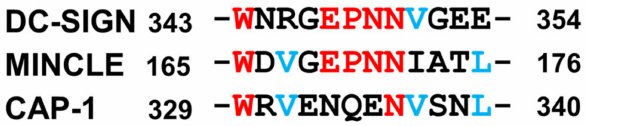
Figure 10. EPN sequence among DC-SIGN and Mincle, and similar sequence in CAP-1 Identical amino acids among 3 sequences were shown in red and between CAP-1 and Mincle of DC-SIGN were in